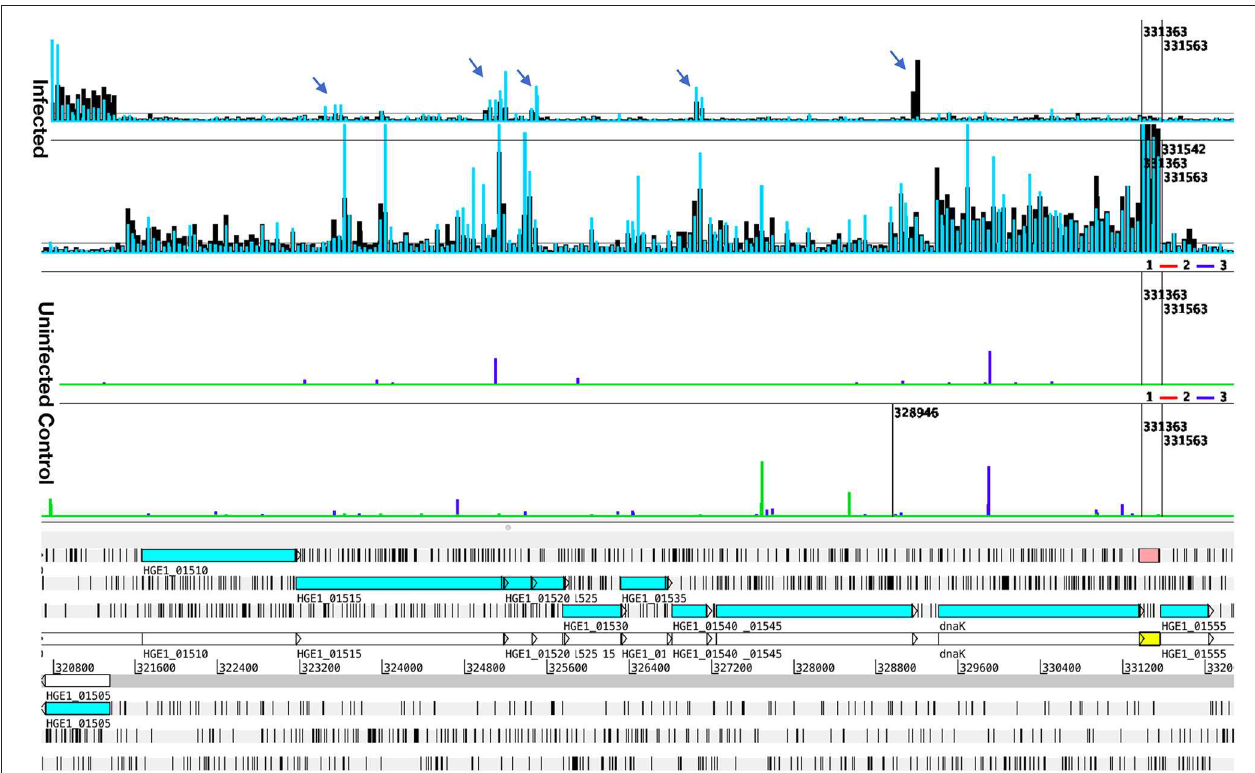
FIGURE 4 | Transcript levels in Samples 6 and 8, illustrating antisense signals and transcription from an unannotated gene. Transcription data (top four graphs) plotted over the annotated genome sequence (sections at the bottom; turquoise boxes denote coding regions of annotated genes) of A. phagocytophilum (Ap) strain HGE1 using the Artemis genome browser. Blue and black bars (top two graphs) represent Ap transcription in sample 6 (Ap replicating in HL-60 cells for 24h, blue bars), and in and sample 8 (Ap replicating in human granulocytes, PMN, for 24h, black bars). Each bar corresponds to one 60-mer probe on the tiling array. The bottom (Uninfected) graphs depict lack of signal from uninfected controls (HL-60 green, PMN blue). Antisense signals from infected HL-60 cells and granulocytes are indicated (arrows). A strong transcription signal (pink box) is visible from an unannotated gene immediately downstream of dnaK. Nucleotide positions in the genome are indicated by numbers above the gray